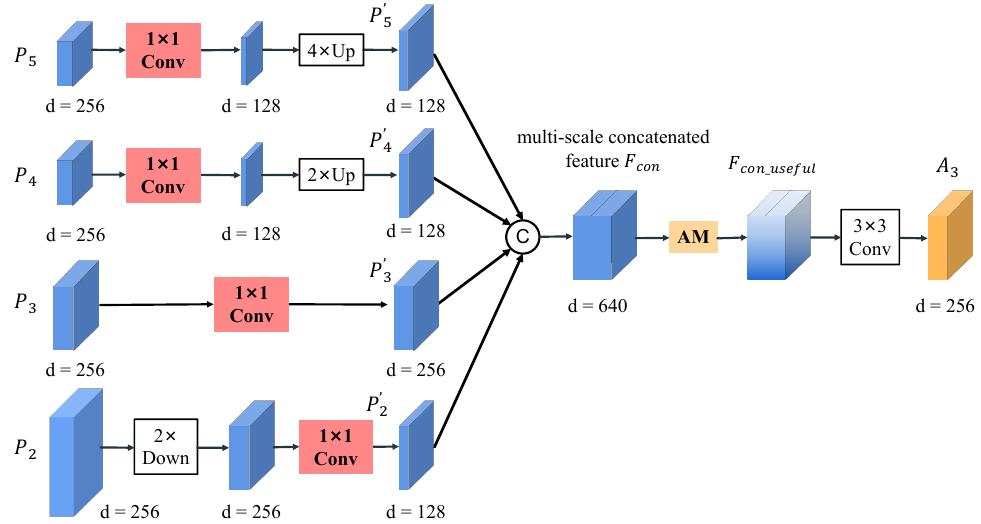
Figure 4. Structure of the proposed A-MLFFM, taking the generation of A 3 as an